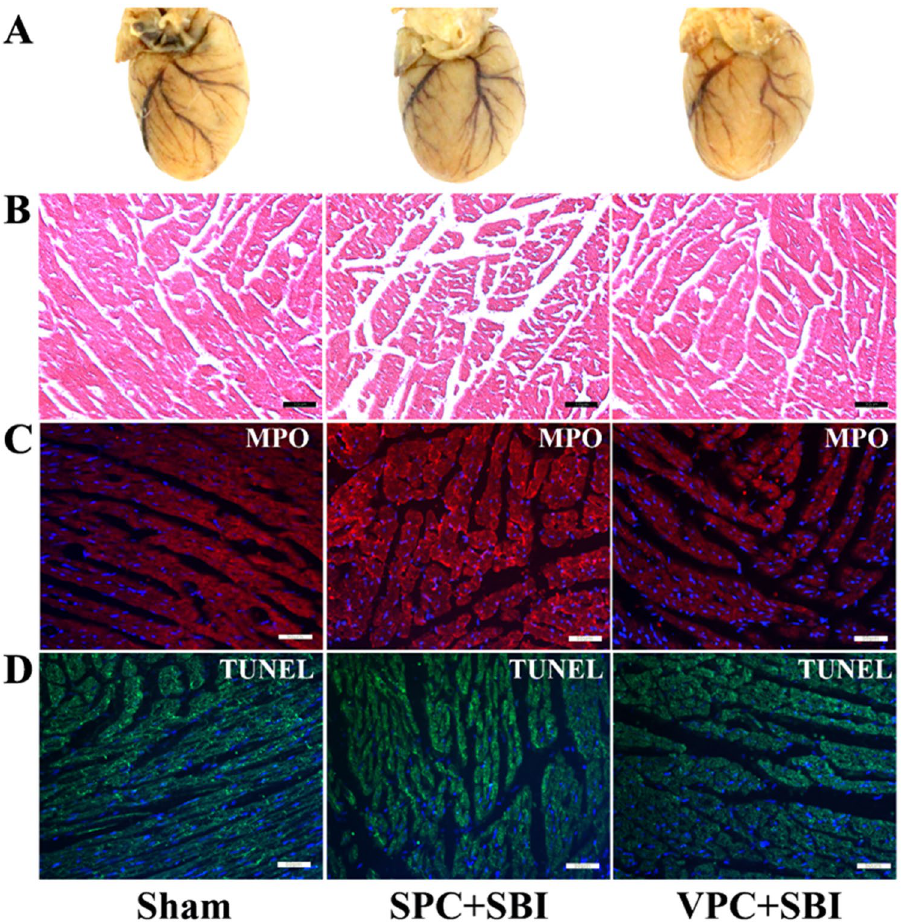
Figure 7. Effect of venom preconditioning (VPC) on the cardiac muscles 24 h after SBI. (A) Gross cardiac shape, (B) H&E staining, scale bar = 10 μ m, (C) MPO staining, scale bar = 50 μ m and (D) TUNEL staining, scale bar = 50 μ m. There was no significant difference in cardiac morphology in the SPC + SBI and VPC + SBI groups compared to Sham. All the pictures are representative of 3 animals per